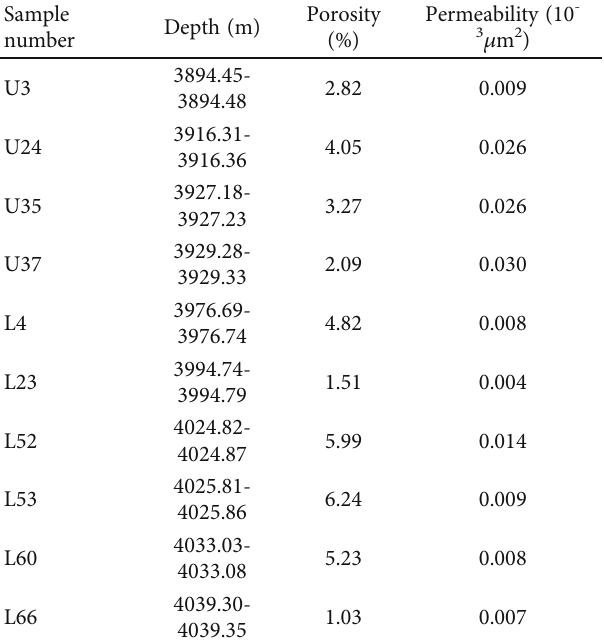
Table 2: The petrophysical information of target samples in LZ region (U and L represent samples from Upper and Lower Longmaxi Formation,